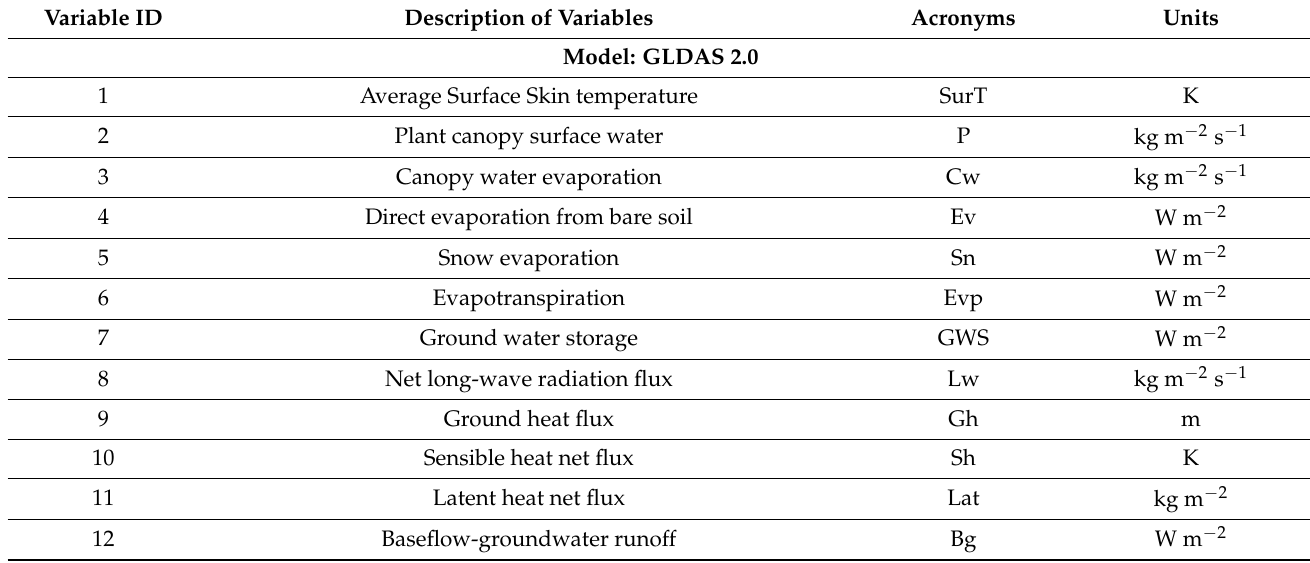
Table A1. Description of the global pool of 53 predictor variables used to design and evaluate the hybrid CEEMDAN-CNN-GRU predictive model for mean sea level